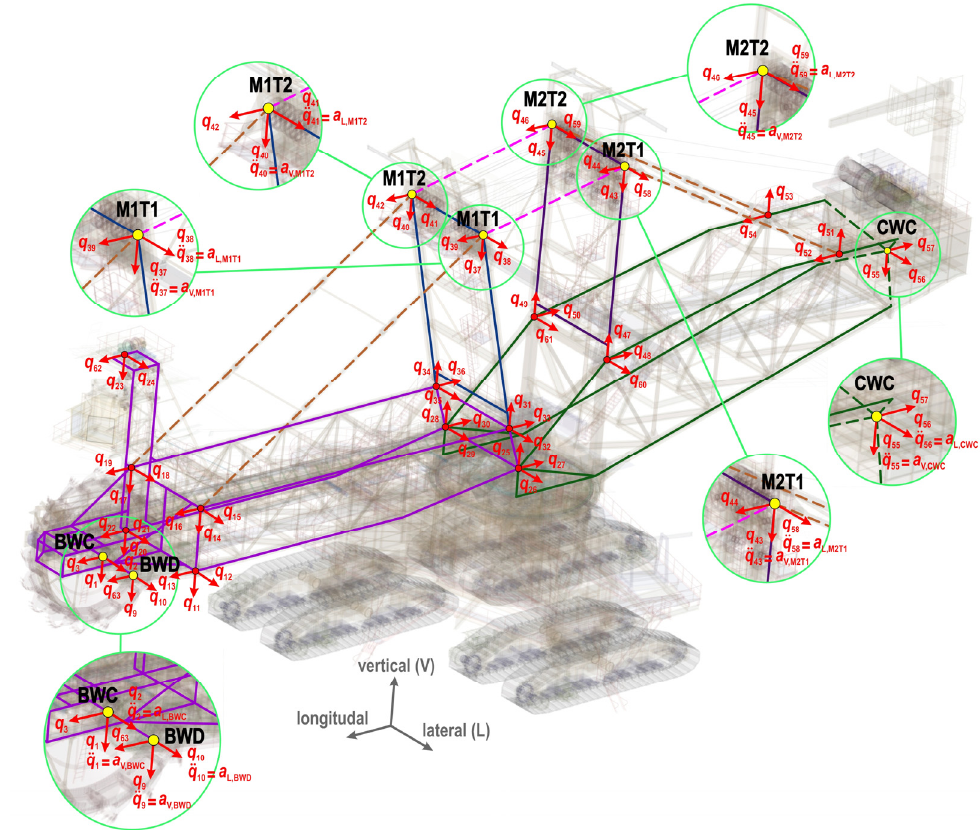
Figure 2. Referent points of the spatial reduced dynamic model of the slewing superstructure of the BWE SchRs 1600: BWC—bucket-wheel center; BWD—center of gravity of the gearbox of the bucket-wheel drive; M1T1—Mast 1, Tip 1; M1T2—Mast 1, Tip 2; M2T1—Mast 2, Tip 1; M2T2—Mast 2, Tip 2; CWC—counterweight center of gravity.